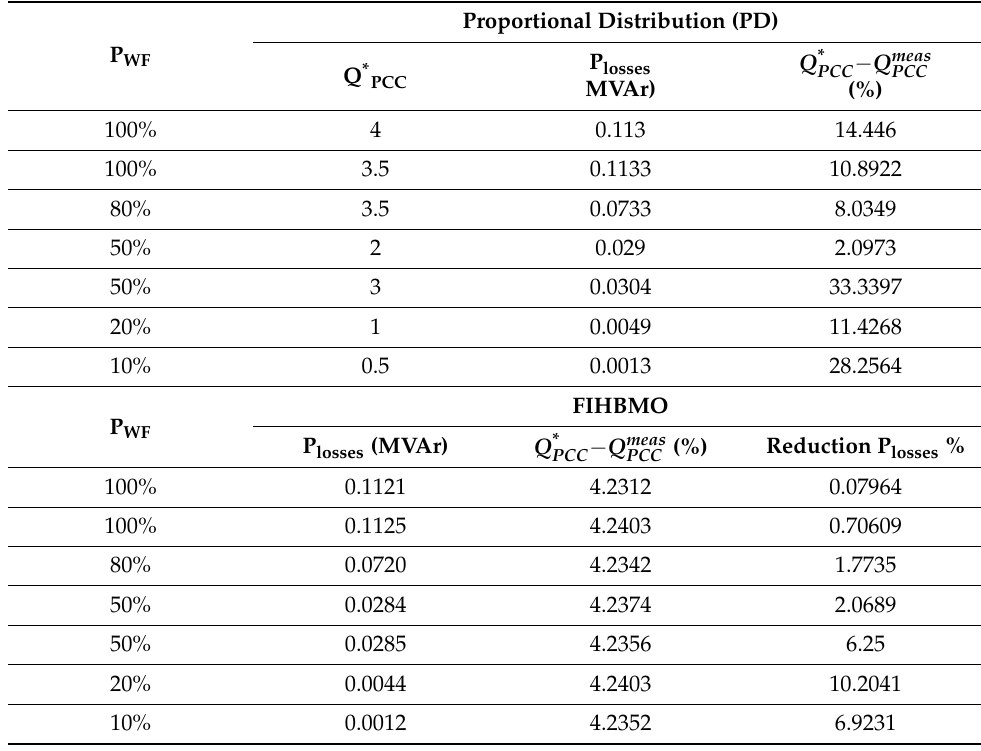
Table 7. Results for Strategy I; comparison between proportional distribution and proposed FIHBMO Method.